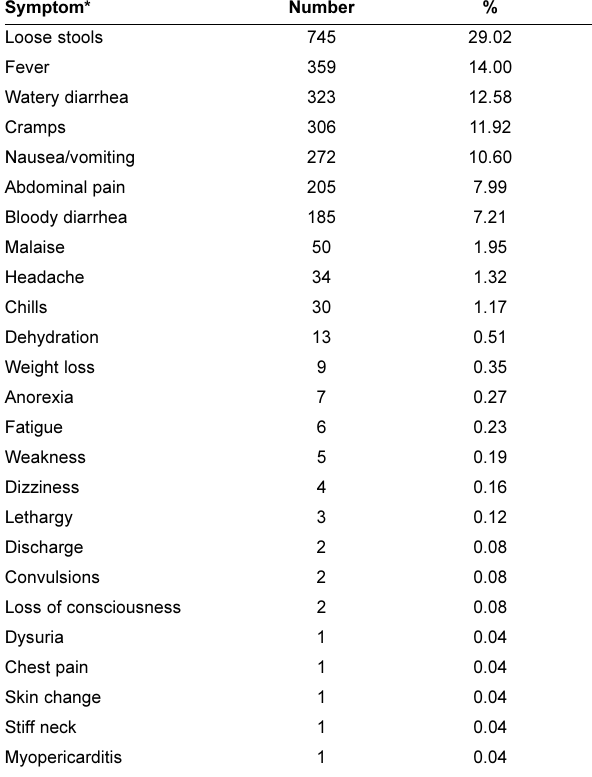
TABLE 2 Frequency distribution of symptoms reported for cases